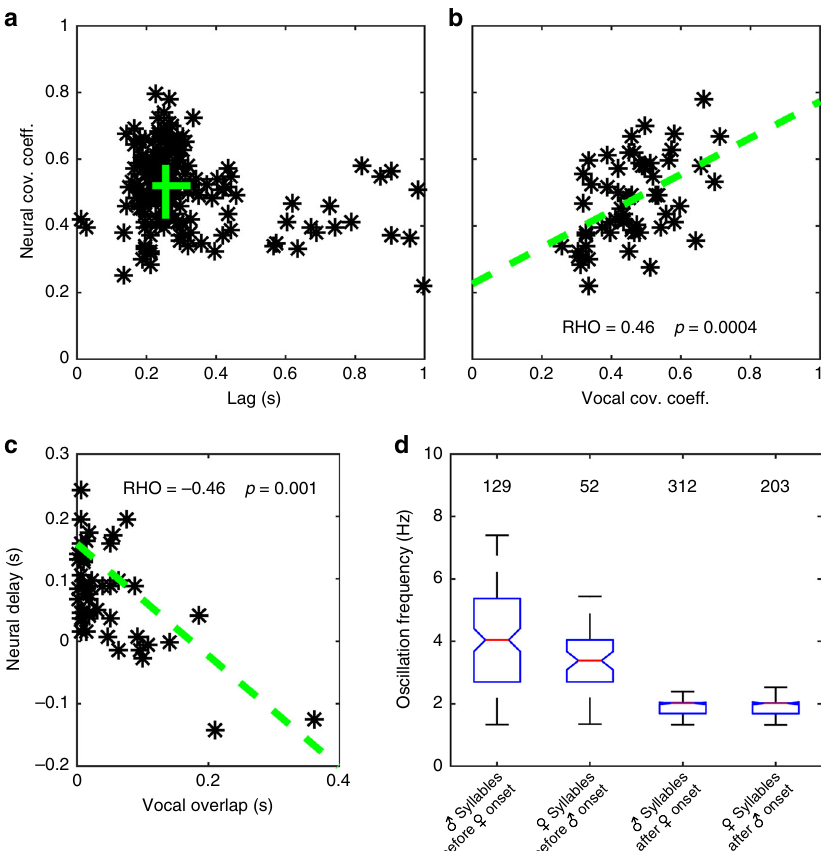
Fig. 5 Quanti fi cation of temporal properties of HVC premotor activity during duetting. a Time lags of maximum cross-covariance between male and female neural signals (root-mean-square envelopes) during 179 duet bouts produced by three bird pairs were clustered at approximately 250 ms. The green lines indicate interquartile ranges of lags and cross-covariance coef fi cients, and their intersection is at the medians of the distributions. b The covariance of neural signals was strongly correlated with the covariance of vocal signals. The dashed green line represents the regression line. n = 56 duet bouts of three bird pairs. c The degree of overlap in neural activity was strongly correlated with the degree of syllable overlap. The dashed green line represents the regression line. n = 47 overlaps produced by two bird pairs. d During emission of duet-initiating syllables, oscillation frequencies of the male and female neural signals were signi fi cantly higher ( p < 0.005, Mann – Whitney U test) than during emission of alternating syllables during duetting. Labeling